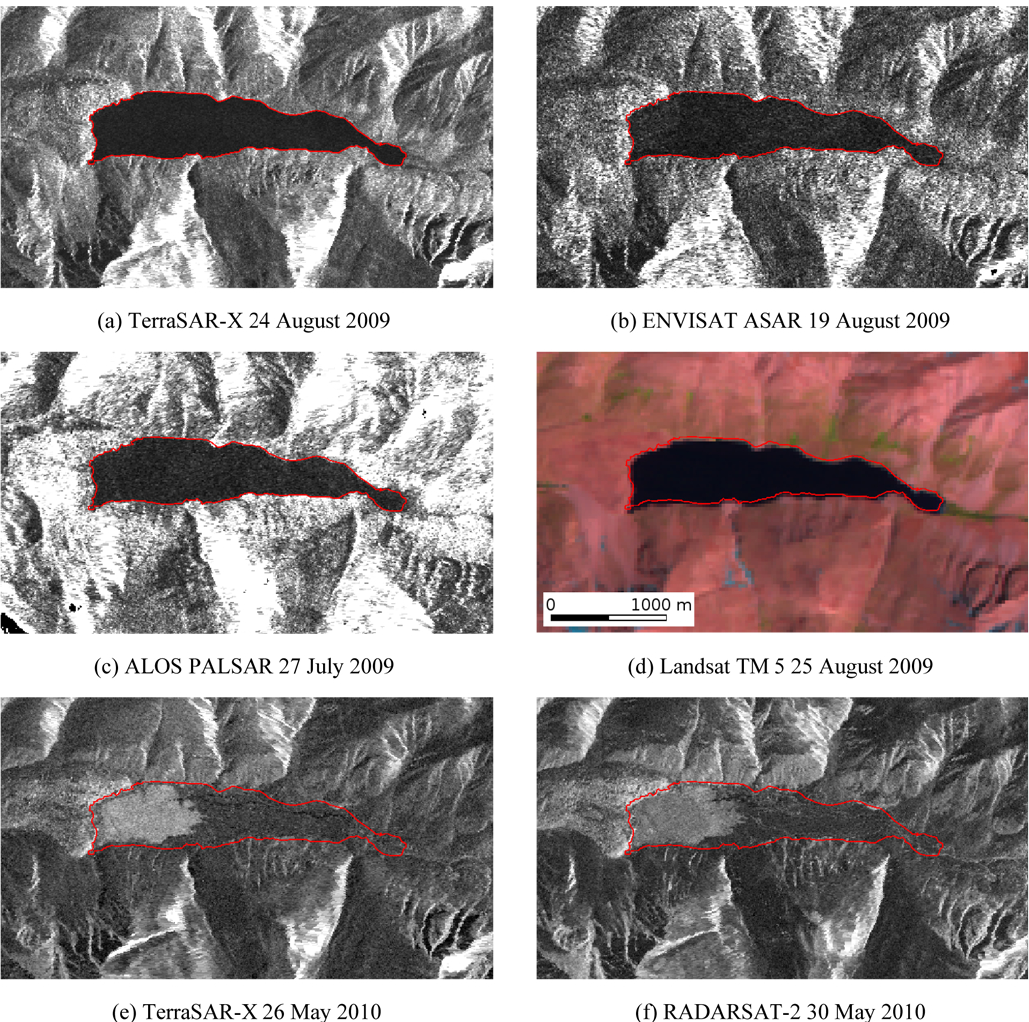
Fig. 5. Terrain-corrected geocoded TerraSAR-X, ENVISAT ASAR, ALOS PALSAR and Radarsat-2 images for summer 2009 and the early spring 2010 for Rivakkul Lake in the test-area in Tajikistan. The outline of the lake, determined in the summer TerraSAR-X intensity image, is shown in red. Layover and shadow are masked in black. A coincident Landsat 5 TM image is presented for